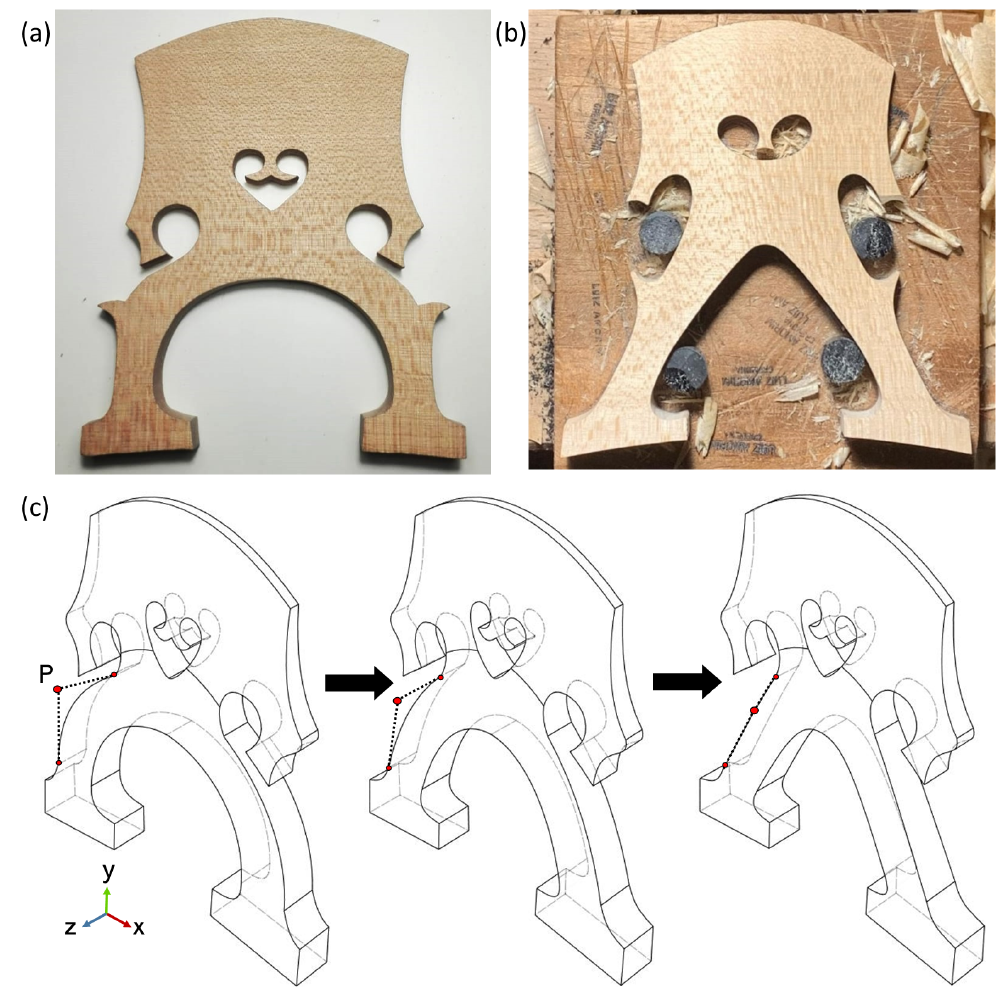
Figure 1. ( a ) Picture of a French model cello bridge blank (courtesy of luthier Matteo Pontiggia). ( b ) Picture of Amorim’s Model X blank during the final construction stages (courtesy of luthier Luiz Amorim). ( c ) Three examples of our 3D model and its evolution as we vary the control parameter of the